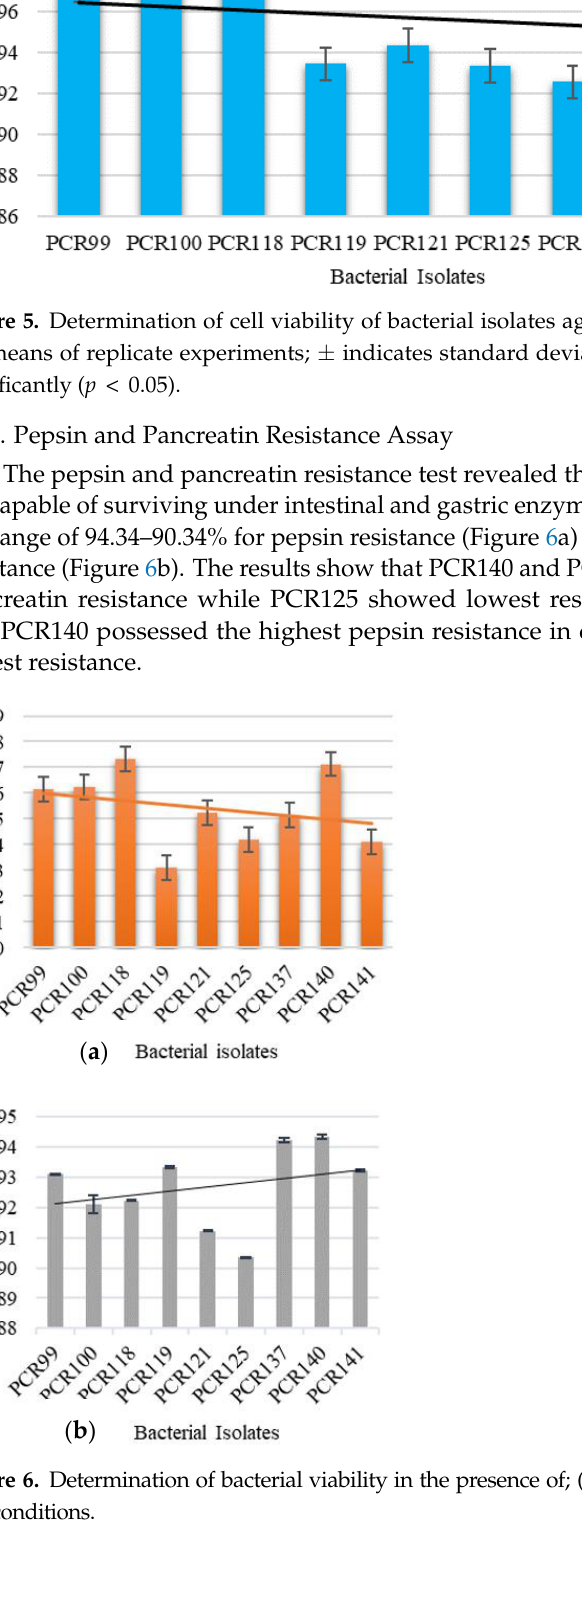
Table 3. In vitro antioxidant of the PCR140. ID